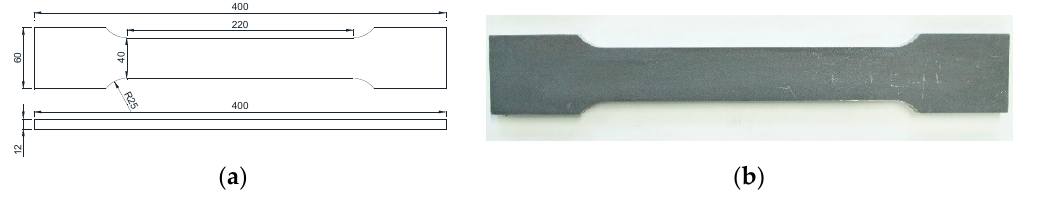
Figure 1. Specimen for testing the material properties: ( a ) Schematic diagram of the specimen; ( b ) picture of the specimen prepared using the base material (unit: mm).